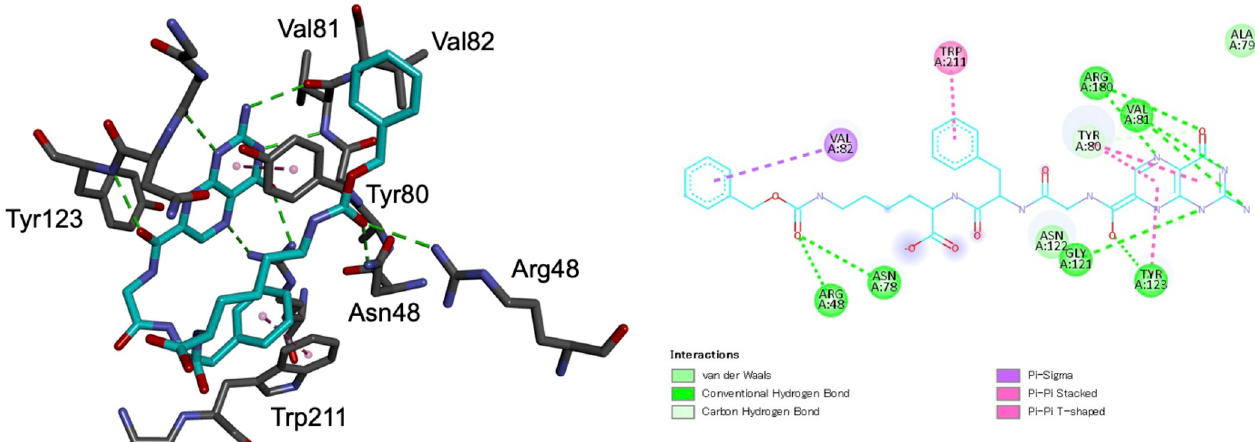
Fig 3. Interactions between 4b and RTA. All interactions were detected and visualized by Discovery Studio Visualizer [11] in both 2D (right) and 3D (left) styles.